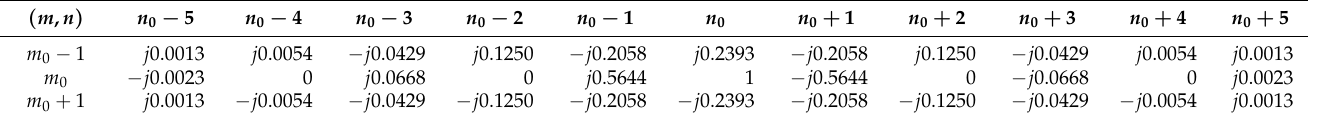
Table 1. The value of coefficient γ m 0 , n 0 m , n of intrinsic interference corresponding to the m th subcarrier of the n th FBMC symbol to the m 0 th subcarrier of the n 0 th FBMC symbol